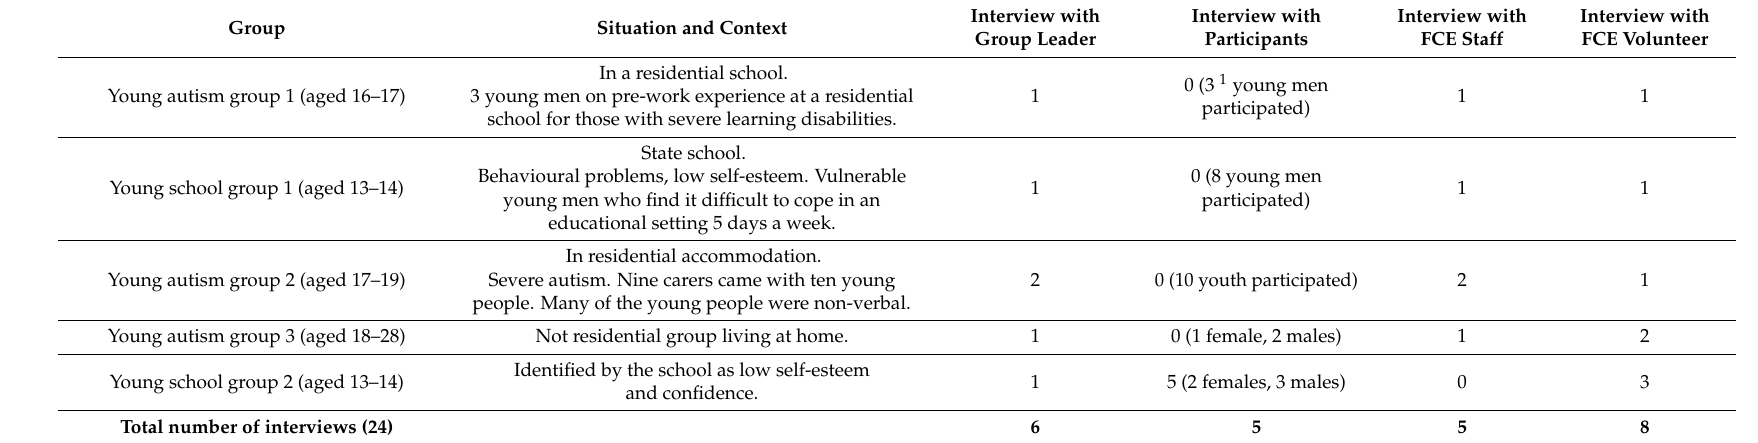
Table 2. The five youth groups involved in the research.